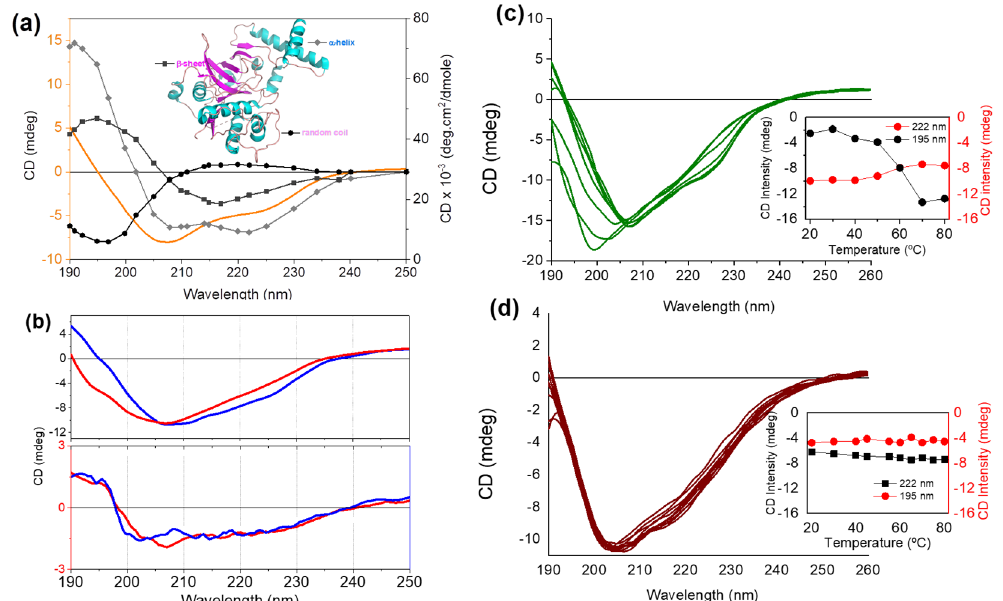
Figure 3. Structural characterization and stability of Bro and NanoBro by circular dichroism (CD) spectroscopy. ( a ) HEPES buffered Bro solution spectrum overlapped with CD spectra of three pure secondary structures, α -helix, β -sheet, and random coils obtained from [27]. The inset shows the PDB structure of a recombinant bromelain (code 6U7D) to illustrate the presence of these structures in the enzyme. ( b ) Effect of storage time on the Bro (upper panel) NanoBro (lower panel) secondary structures. Blue and red lines correspond, respectively, to the CD spectra obtained immediately and two weeks after storage. ( c , d ) Effect of temperature in the range of 20–80 °C on the CD spectra of Bro solution and NanoBro, respectively. The native protein in aqueous solution 0.2 mg/mL has pH 5.2 and colloidal suspension of NanoBro, pH 6.5. Table 1. Summary of the estimate of the percentage of secondary structures found in Bromelain under various experimental conditions according to data obtained by Circular Dichroism and ana- lyzed by BeStSel.